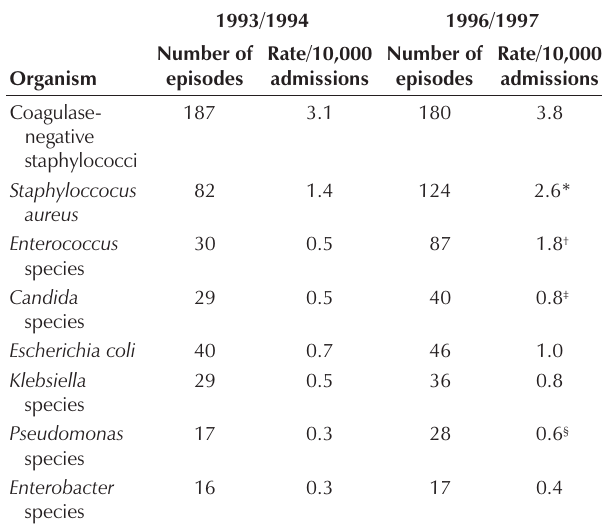
Organism-specific nosocomial blood stream infections at the University of Alberta